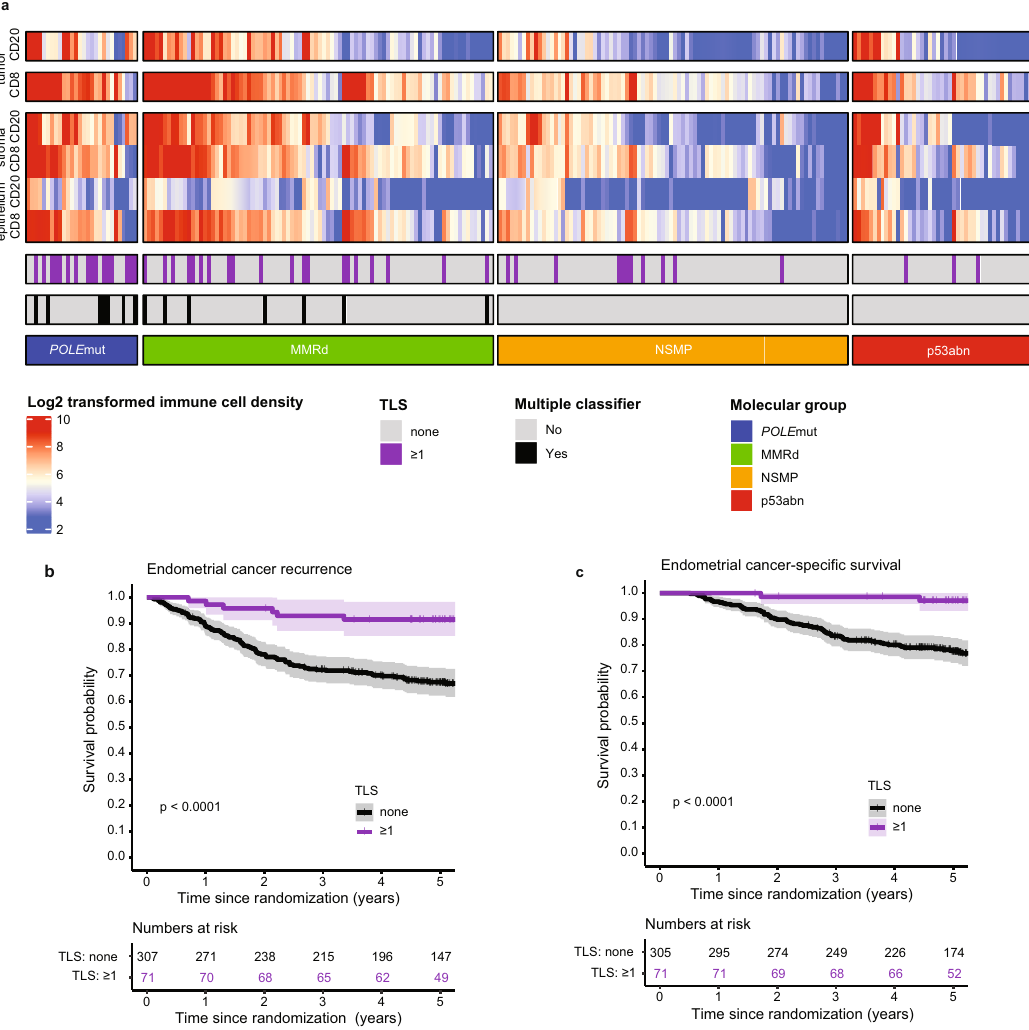
Fig. 4 Relation between molecular group, TLS and CD8 densities and prognosis in high-risk endometrial cancer. a Heat map of included PORTEC-3 patients ( N = 378) with available data on molecular classi fi cation, TLS, CD8 + and CD20 + densities ( N = 252). Each patient is represented by a row in the graph. Clustering of CD8 + and CD20 + densities strati fi ed by molecular group was done by hierarchical clustering using Ward ’ s minimum variance method. b Endometrial cancer recurrence-free survival calculated according to Kaplan-Meier ’ s methodology using the log rank test (two-sided alpha of 0.05) for all included PORTEC-3 patients ( N = 378). c Endometrial cancer-speci fi c survival calculated according to Kaplan-Meier ’ s methodology using the log-rank test (two-sided alpha of 0.05) for all included PORTEC-3 patients ( N =